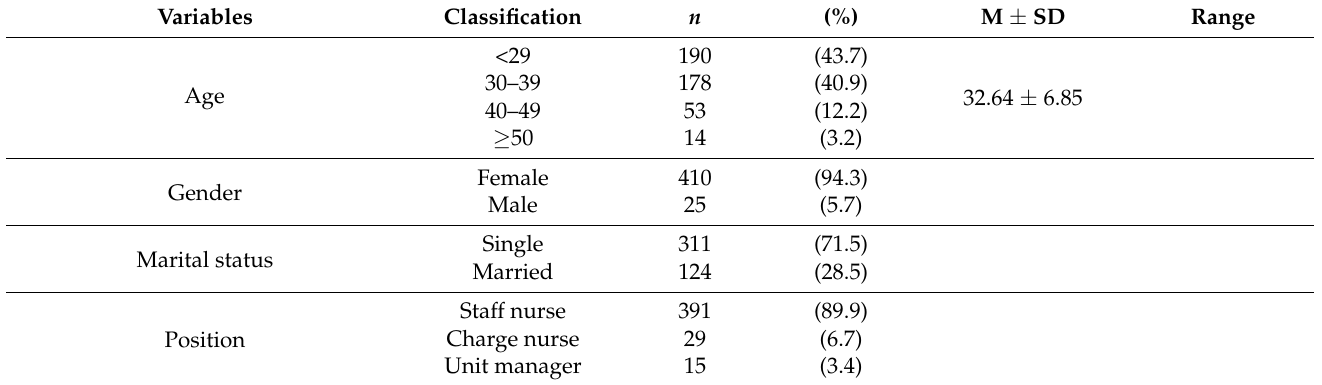
Table 1. Participant characteristics ( n =